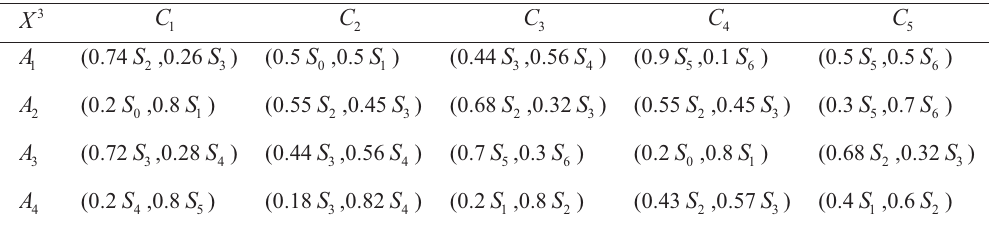
Table 3. The linguistic evaluation matrix 3 X provided by the decision maker